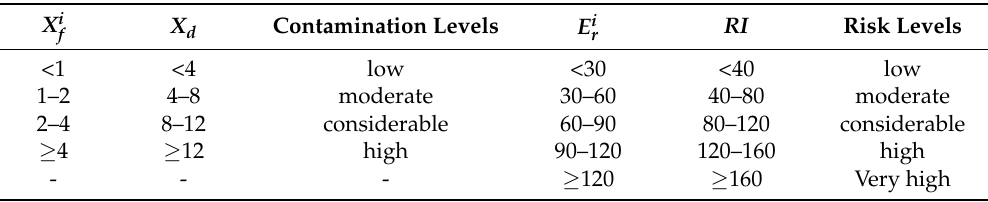
, X d , E i r and RI f